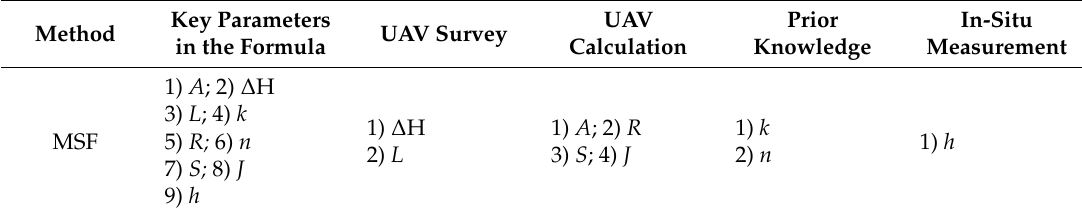
Table 1. Parameters used in the calculations of the formula.